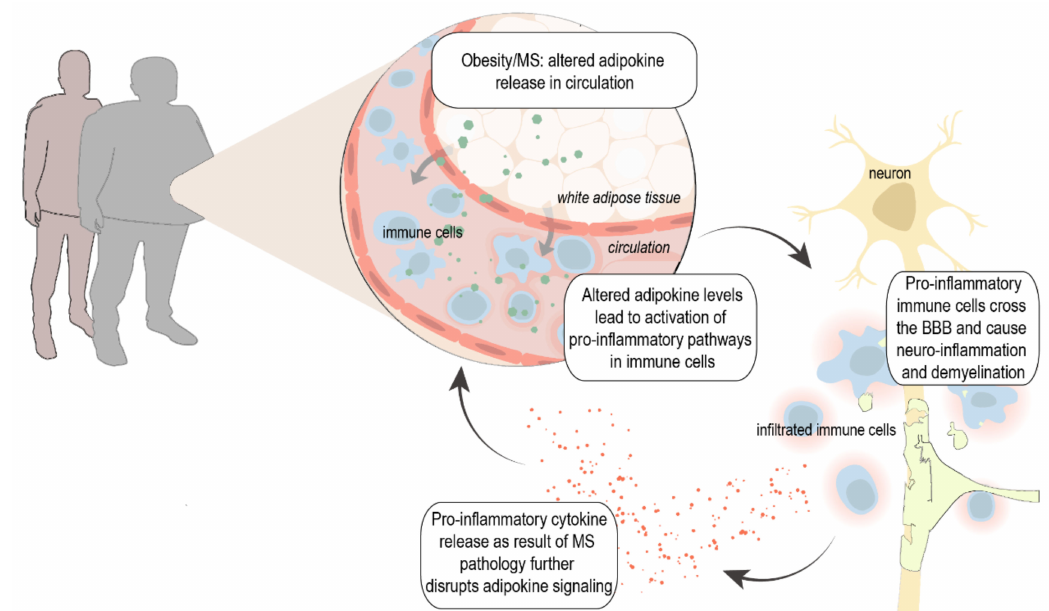
Figure 1. Proposed hypothesis: Obesity and MS can lead to altered adipokine release from white adipose tissue (WAT) into circulation. This results in the activation of inflammatory pathways and increased infiltration of immune cells in the CNS. On the other hand, increased levels of pro-inflammatory cytokines in MS such as tumor necrosis factor α (TNF- α ), interleukin 6 (IL-6), and interferon γ (IFN- γ ) further stimulate the release of pro-inflammatory adipokines from the WAT and disrupt adipokine signaling, creating a detrimental positive feedback loop. MS, multiple sclerosis; BBB, blood–brain